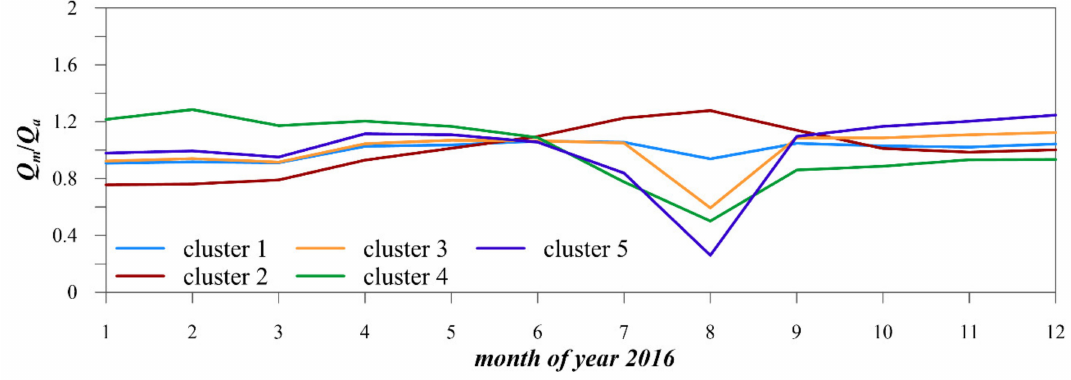
Figure 2. Average nondimensional patterns for the five main di ff erent clusters of consumption behaviours observed in the pilot area ( Q m and Q a are the monthly and annual discharges,